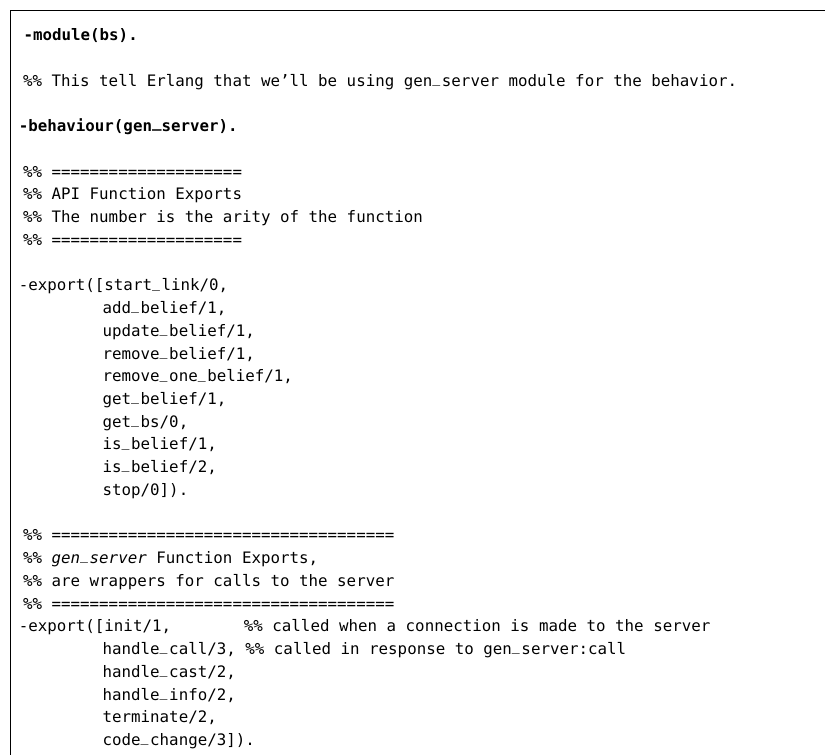
Table 11. Functions managing the